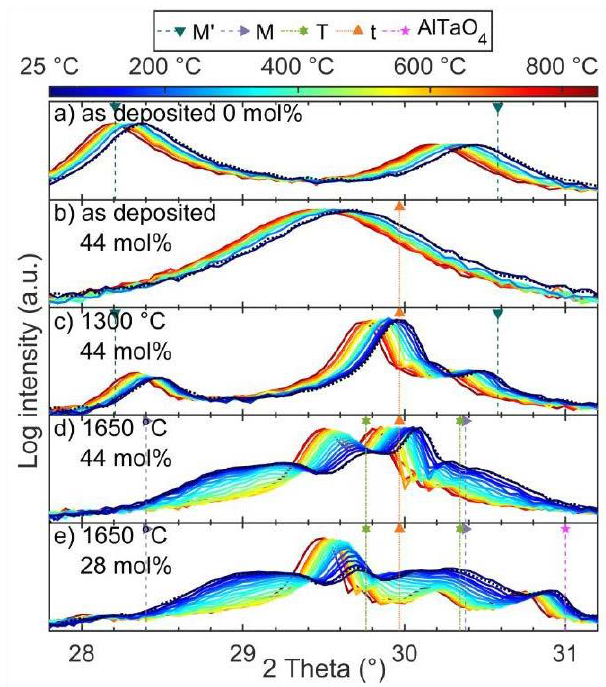
Figure 8. Diffractograms obtained during in situ heating experiments of as-deposited and pre- annealed Y (1 − x)/2 Ta (1 − x)/2 Zr x O 2 coatings. Dotted intensities represent measurements at room tem- annealed Y (1-x)/2 Ta (1-x)/2 Zr x O 2 coatings. Dotted intensities represent measurements at room tempera- ture after completed in situ heating. perature after completed in situ